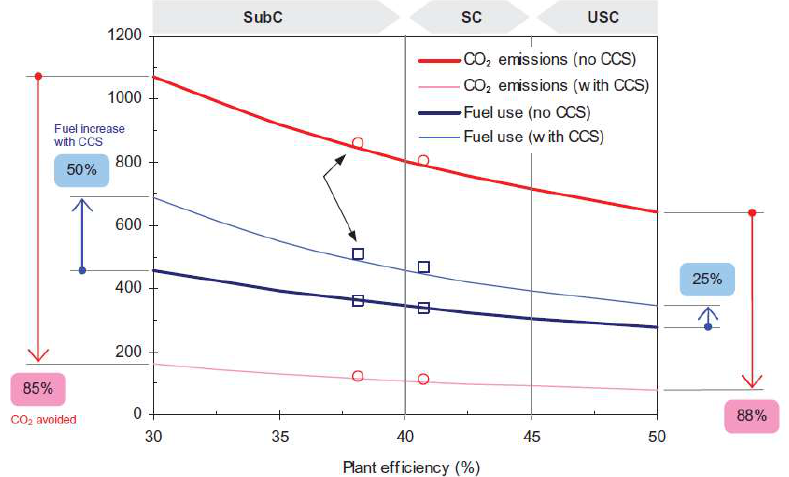
Figure 8. CO 2 emissions vs. efficiency (y-axis: specific CO 2 emissions and fuel consumption in kg/MWh). Calculation was made for a PC plant firing bituminous coal with an LHV of ~26.2 MJ/kg and carbon content of 0.64. CO 2 capture rate of 90% and efficiency penalty of 10% points were assumed when CCS was added